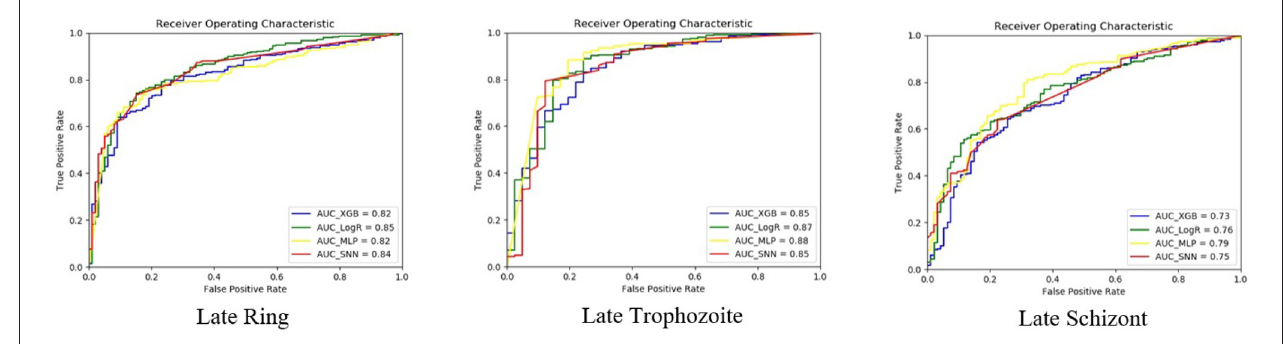
FIGURE 6 | ROC of classification models for each